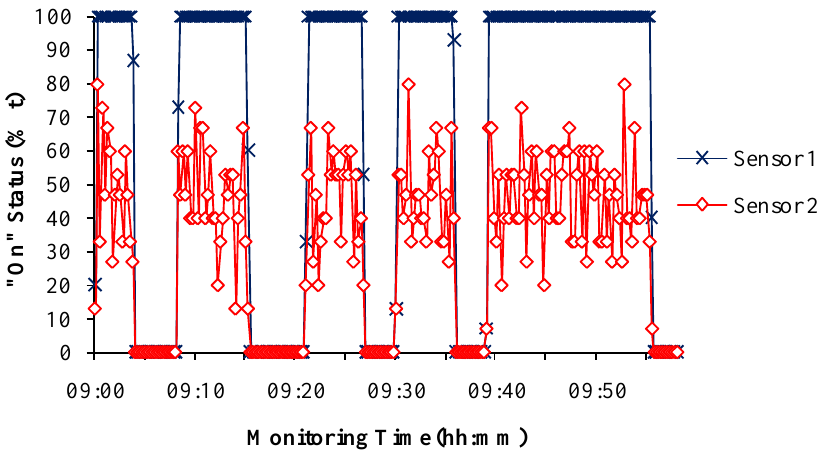
Figure 6. Comparison of a normal sensor (Sensor 1) and a sensor with unsteady sensitivity (Sensor 2) shown in the 15-s data.